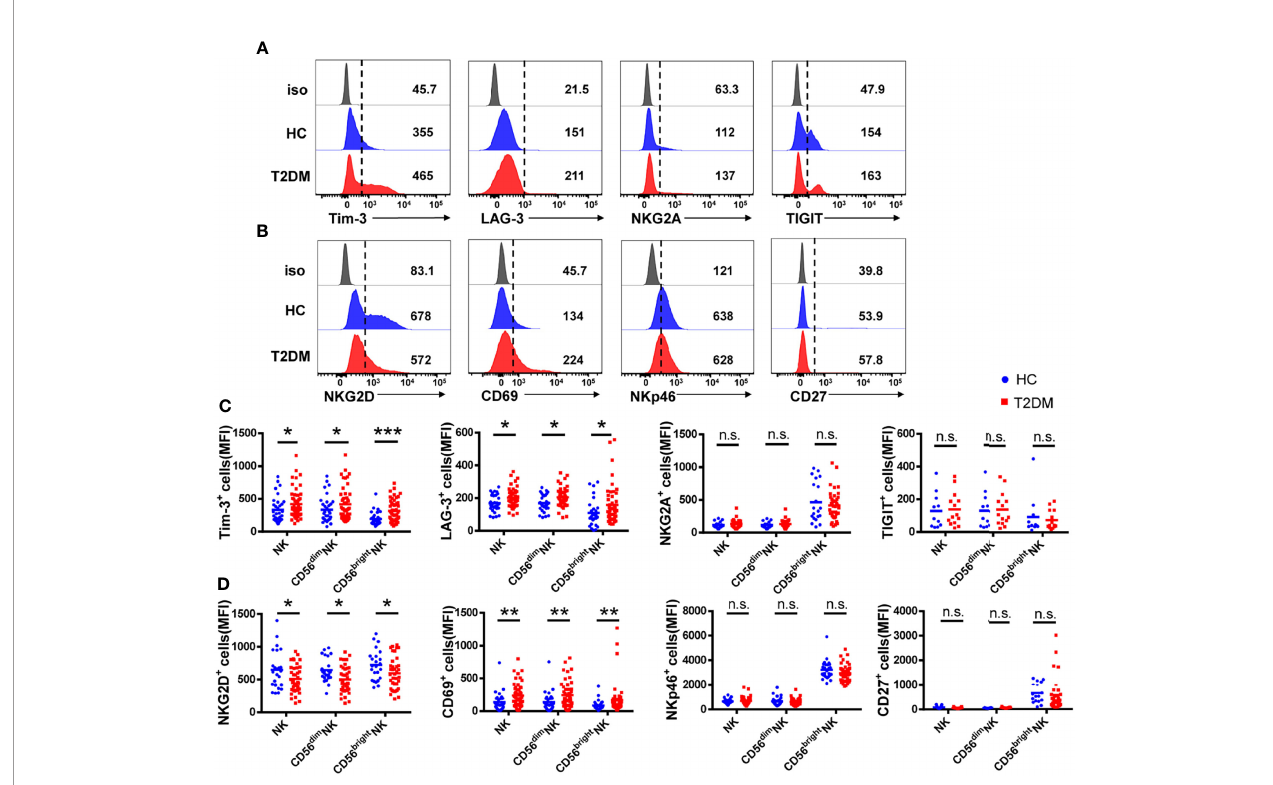
FIGURE 2 | NK cells from T2DM patients have an impaired phenotype. (A) Representative histograms showing the expression of the inhibitory receptors Tim-3, LAG-3, NKG2A, and TIGIT on total NK cells from patients with T2DM and healthy controls (HC). (B) Representative histograms showing the expression of activating receptors NKG2D, CD69, NKp46, and CD27 on total NK cells from patients with T2DM and HC. (C) Comparison of the mean fl uorescence intensity (MFI) of inhibitory receptor expression in total NK cells and NK cell subsets. (D) Comparison of the MFI of activating receptor expression in whole NK cells and NK cell subsets. Data are representative of more than three independent experiments and results are presented as the mean ± SEM; *p < 0.05, **p < 0.01, ***p < 0.001, n.s., not signi fi cant. See also Supplementary Figure S2